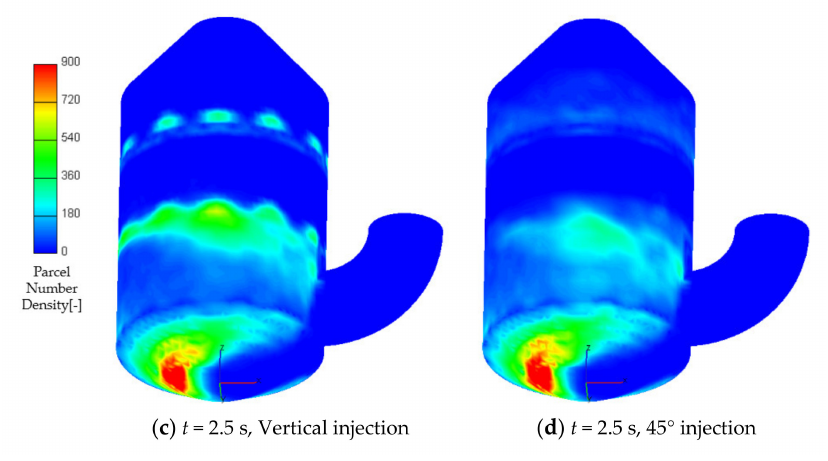
Figure 18. 3D distribution of the droplets.